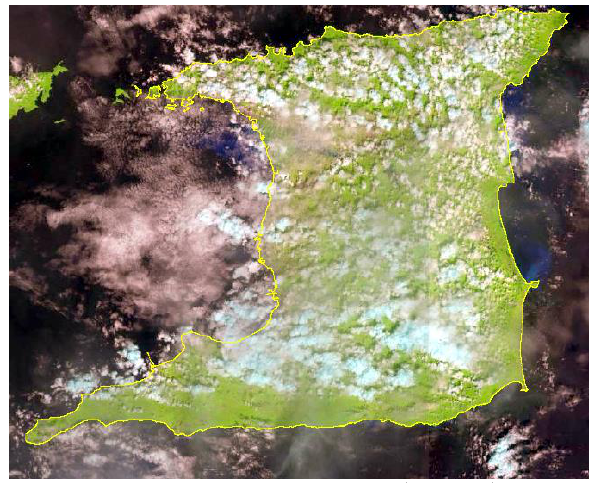
Figure 2. Sentinel-2 RGB image (21-10-18)